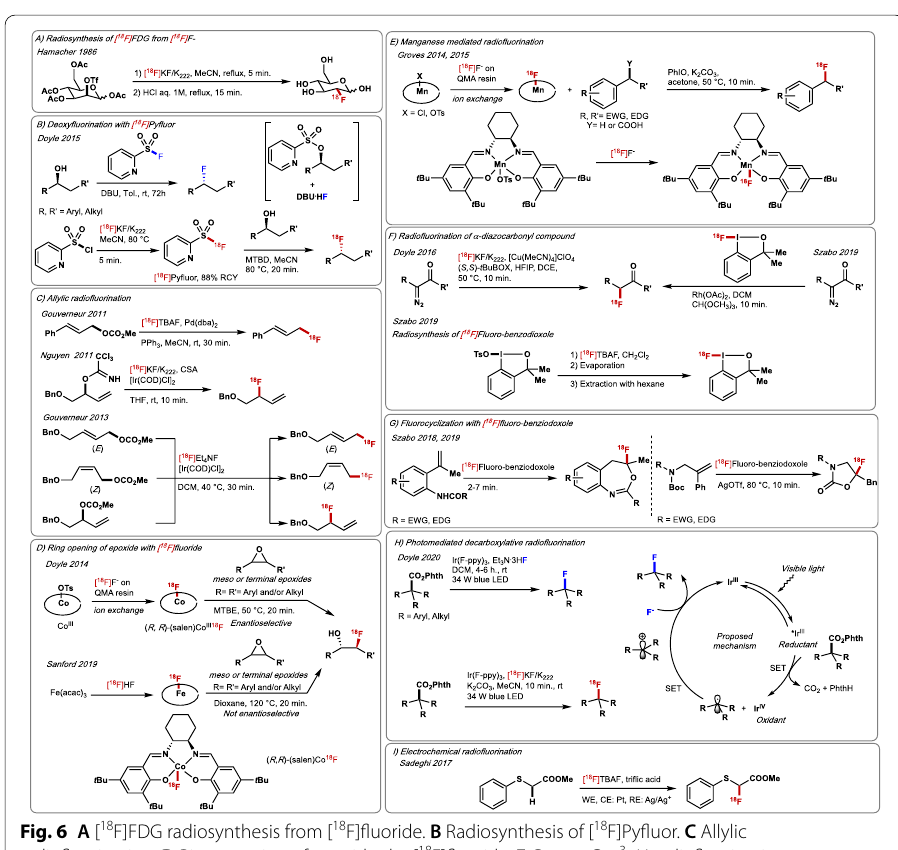
Fig. 6 A [ 18 F]FDG radiosynthesis from [ 18 F]fluoride. B Radiosynthesis of [ 18 F]Pyfluor. C Allylic radiofluorination. D Ring opening of epoxides by [ 18 F]fluoride. E Groves Csp 3 –H radiofluorination and 18 F-fluorodecarboxylation. F Radiofluorination of α-diazocarbonyl compound. G Oxidative 18 F-fluorocyclization. H Photo-mediated decarboxylative radiofluorination of activated esters. I Electrochemical radiofluorination. EWG electron-withdrawing group. EDG electron-donating group. = =